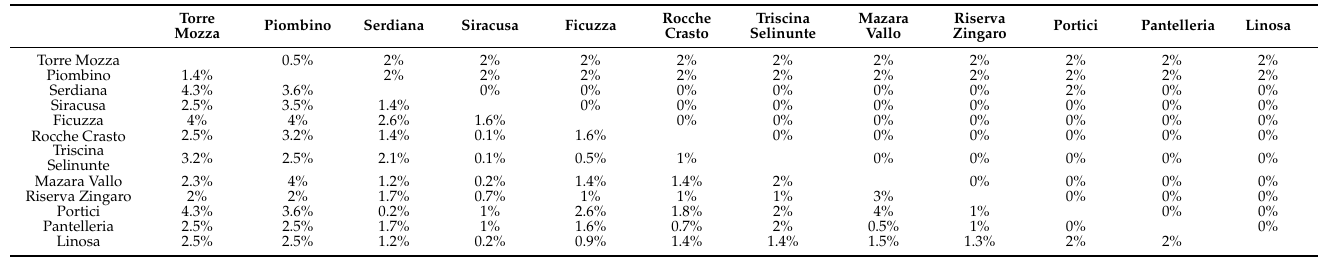
Table 3. Genetic distances calculated among the studied populations of Chalcides ocellatus with cytb distances above diagonal and 12S + COXI below the diagonal.